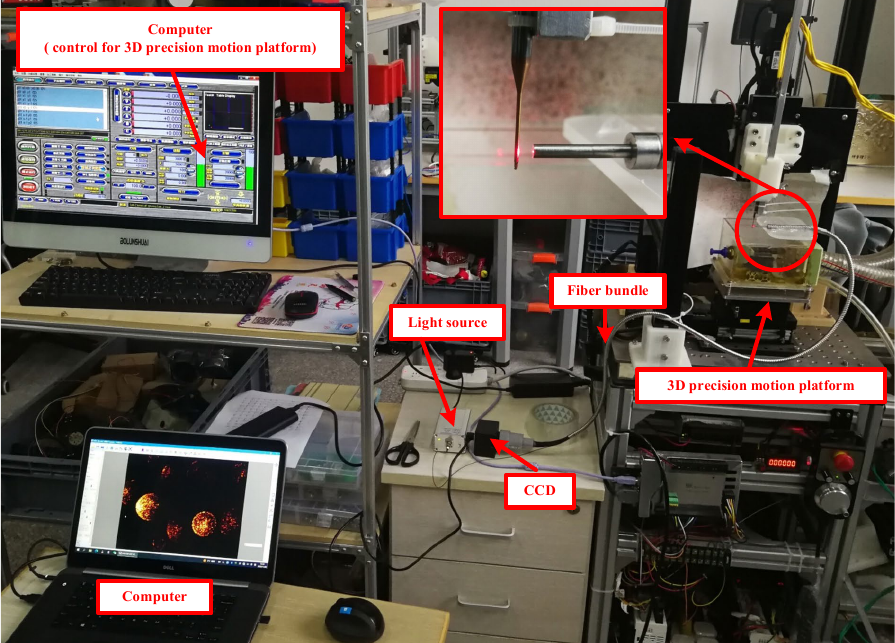
Figure 4. Measurement system setup in 3D precision motion